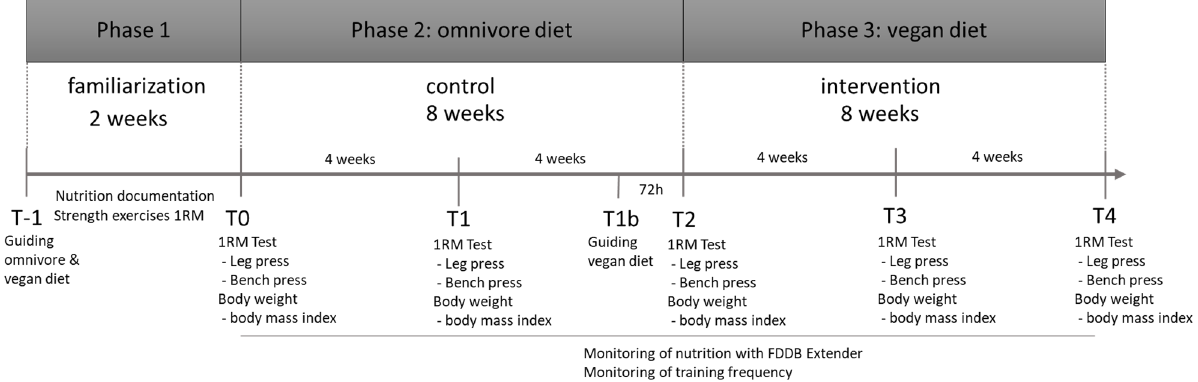
Figure 1. Study Design—presentation of the temporal course of the study. All 3 phases are shown with their measurement points. (1 RM = One repetition maximum test).